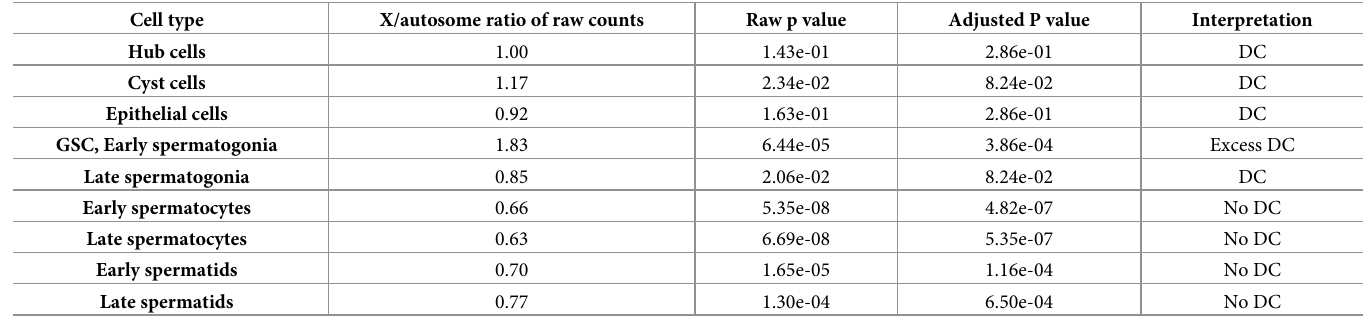
Table 1. X and autosomal count ratios detected per gene for every cell type. These ratios are of raw counts from X and autosomes, not log transformed. The ratio of X/ autosome expression is close to or greater than 1 in hub, cyst, GSC, early spermatogonia and late spermatogonia, indicating the presence of dosage compensation. Late spermatogonia may also be interpreted as no DC if they contain most transcripts generated from early spermatogonia. This ratio decreases in meiotic and post-meiotic cells, indicating the loss of dosage compensation. P values are for a two-sided Wilcoxon test with a null hypothesis that X and autosome genes are similarly expressed, inter- preted as dosage compensation. Meiotic and post-meiotic cells show an imbalance in x-autosome ratios, indicative of absent dosage compensation, but in pre-meiotic and somatic cells, x and autosomal ratios are near or over 1. The X/autosome ratio is highest in GSC/early spermatogonia, with a statistical enrichment of X chromosome gene expression, interpreted as possible excess dosage compensation in this cell type. DC means dosage